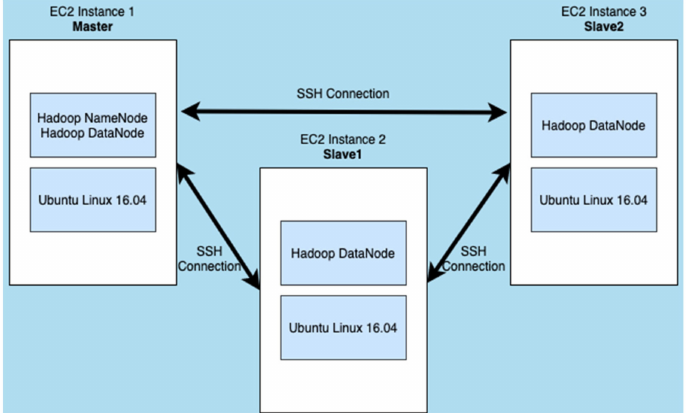
Figure 5. Cloud instances architecture.